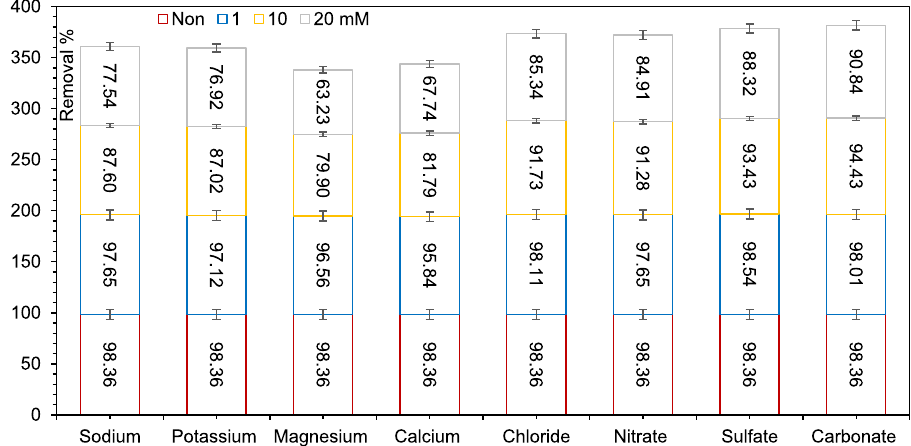
Figure 4. Effect of interfering ions on the efficiency of AZT adsorption under optimized